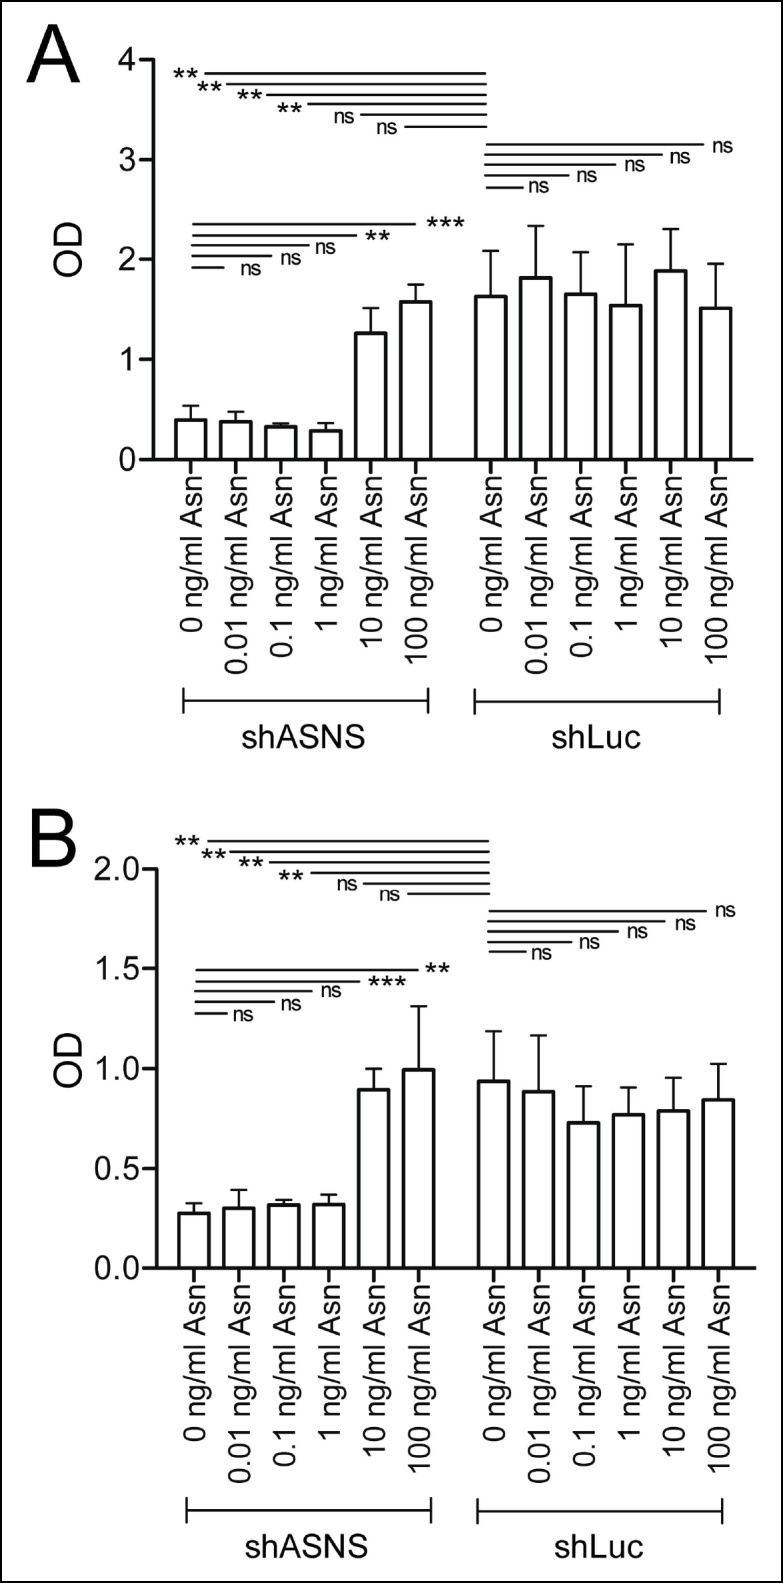
Asparagine concentrations of 10 or 100 mg/L reverse the effects of ASNS silencing on sarcoma growth.Kras;p16p19null RMS and NMS cells were transduced with shASNS- and shLUC-lentivirus. Transduced cells were cultured in the presence of increasing concentrations of asparagine (0.01 – 100 mg/L). Asparagine at 10 or 100 mg/L reversed the growth-inhibitory effects of ASNS silencing on Kras;p16p19null RMS (A) and NMS cells (B; ns p≥0.05, * p<0.05, ** p<0.01, *** p <0.001; as determined by T-tests).